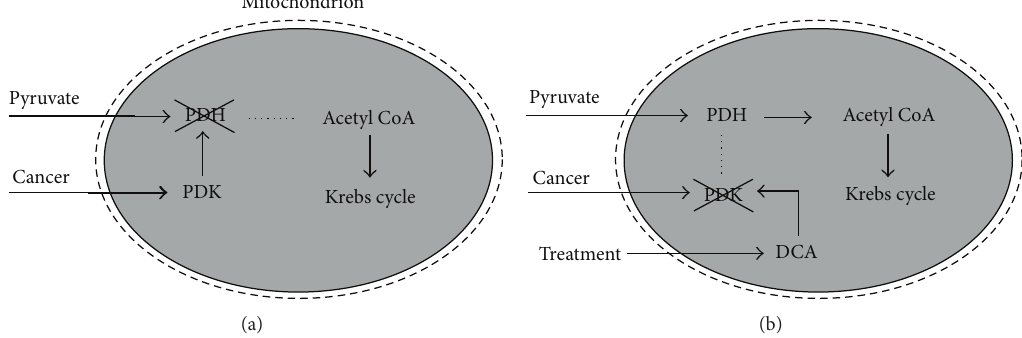
Figure 2: Glycolytic phenotype cancer cell may be treated by DCA (up to now the only known drug capable of restoring normal function of cancer cells). (a) The pyruvate pathway into the mitochondrial matrix space is blocked. PDH (pyruvate dehydrogenase) enzymes in the mitochondrial matrix (the grey area) phosphorylated by kinase PDK are dysfunctional, and pyruvate is not transferred to be broken down into the two-carbon acetyl groups on acetyl CoA (Coenzyme A). (b) DCA inhibits activity of PDK. Function of PDH enzymes is restored, and the pyruvate pathway in mitochondria is open (after [54]). The cell needs sufficient amount of oxygen for normal